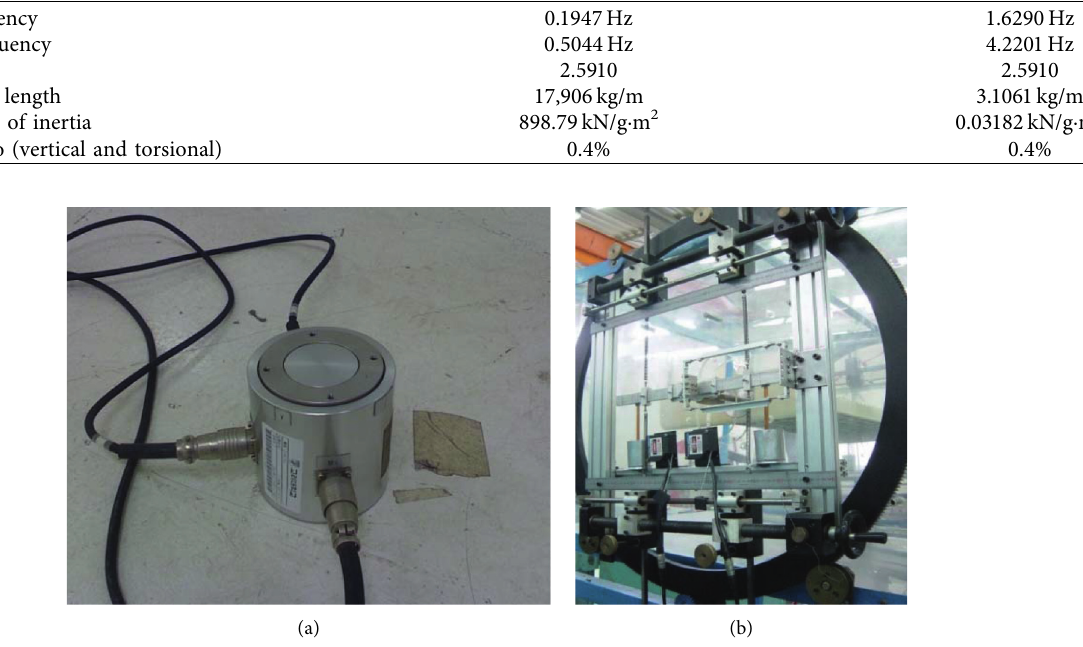
Figure 6: Test setup: (a) 3-component load cell for static test and (b) spring support system for dynamic test. From the measured forces, the static aerodynamic coefficients are calculated